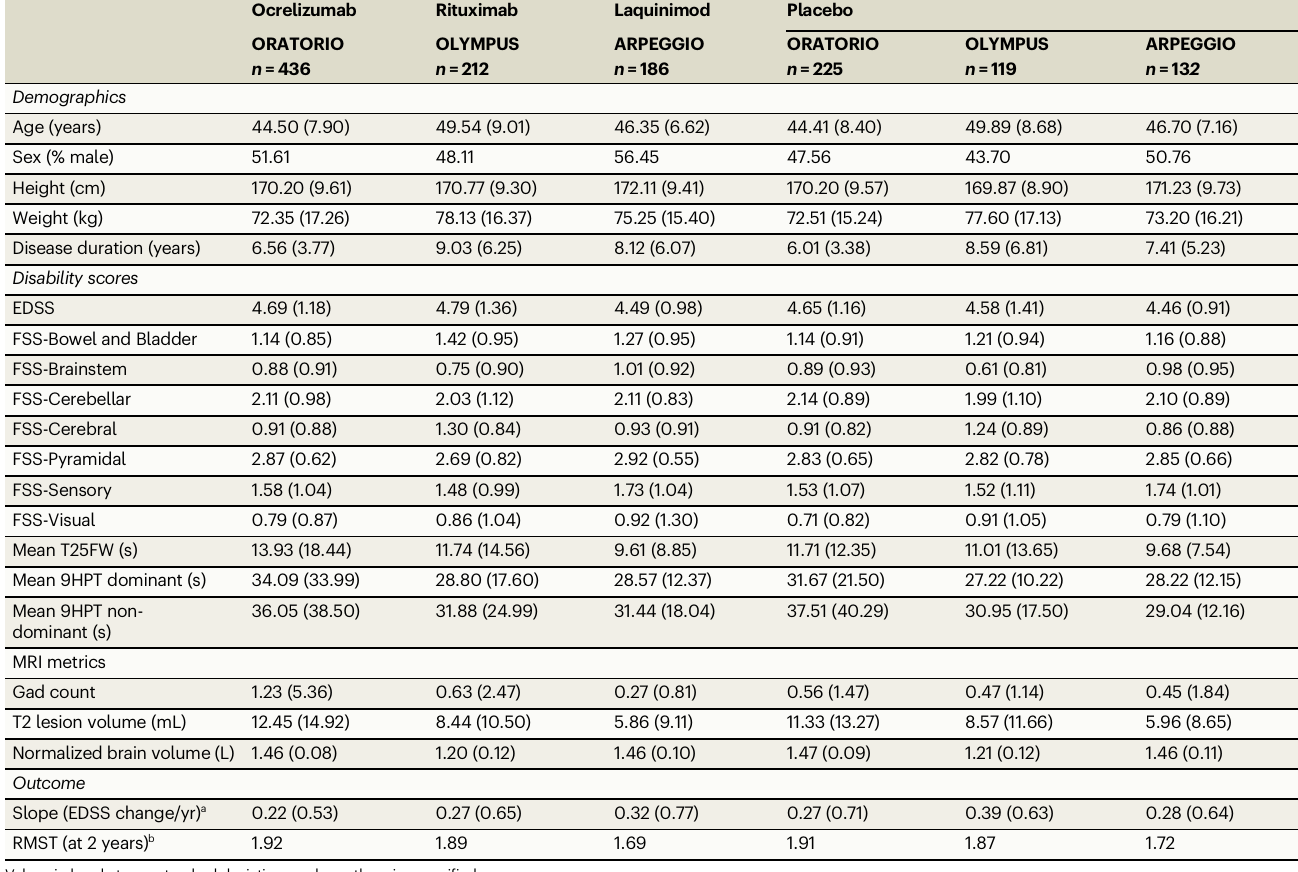
Table 1 | Baseline features and outcomes per treatment